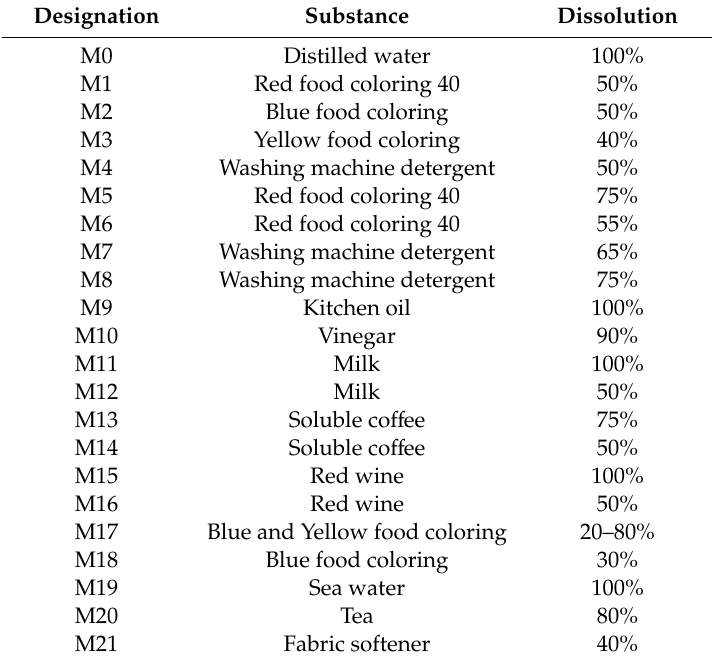
Figure 1. View of the 21 samples used in the present analysis.